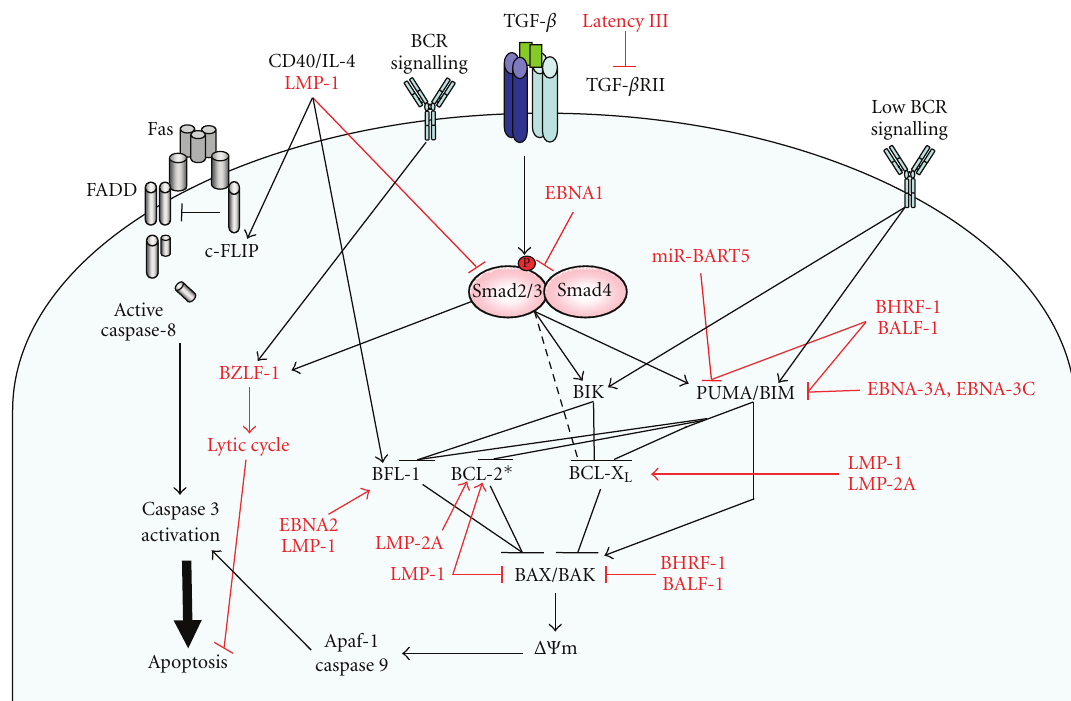
Figure 2: EBV infection impacts on cell death and survival pathways in GC B cells. Interconnected signalling pathways regulate the apoptosis of GC B cells. Proapoptotic signals via B cell receptors and the canonical Smad pathway activated by the TGF- β receptor control the elimination of unwanted B cells by inducing intrinsic apoptosis. Intrinsic apoptosis is dependent on the activation of the proapoptotic BCL-2 family members BAX and BAK, permeabilisation of the mitochondrial membrane ( ΔΨ m ) and release of proapoptotic factors resulting in the activation of the initiator caspase, caspase 9. An extrinsic apoptotic pathway occurs via the death receptor FAS. FAS stimulation results in the formation of the death-inducing signalling complex (DISC) comprised of FAS, the Fas-associated death domain (FADD), and pro-caspase 8. GC B cells, however, have a preformed DISC whose activation is inhibited by binding of the protein cFLIP. The cells are, therefore, dependent on continuous survival signals via CD40 for maintenance of cFLIP levels. CD40 signalling (along with other signals through BLyS (BAFF) and the BCR not shown on this diagram) also induces BCL-2 family members such as BFL-1 and BCL-X L which promote cell survival by inhibiting the intrinsic apoptosis pathway. EBV gene products target multiple points in the apoptosis pathways (shown in red). ∗ In vitro studies of cell lines report the LMP-1-dependent upregulation of BCL-2, however, LMP-1 and BCL-2 expression levels do not correlate in primary